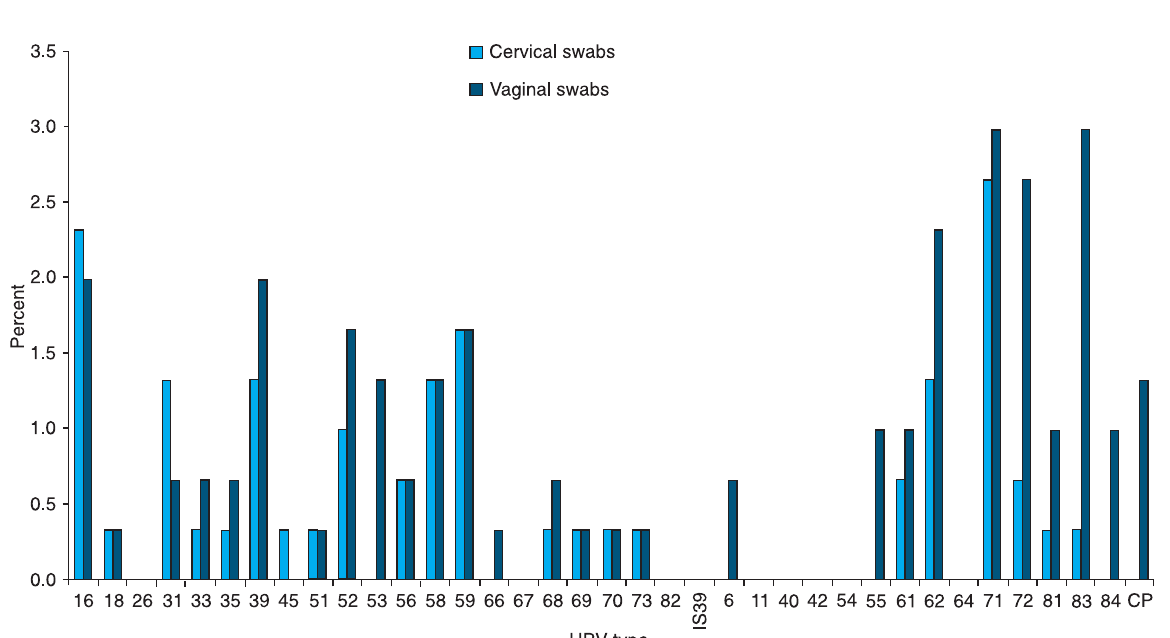
Figure 2. Detection of specific human papillomavirus (HPV) types in cervical and vaginal swab specimens from 302 women. The percent of each HPV detected in the swabs is indicated on the y-axis and the specific HPV types detected in the assay are shown on the x-axis.